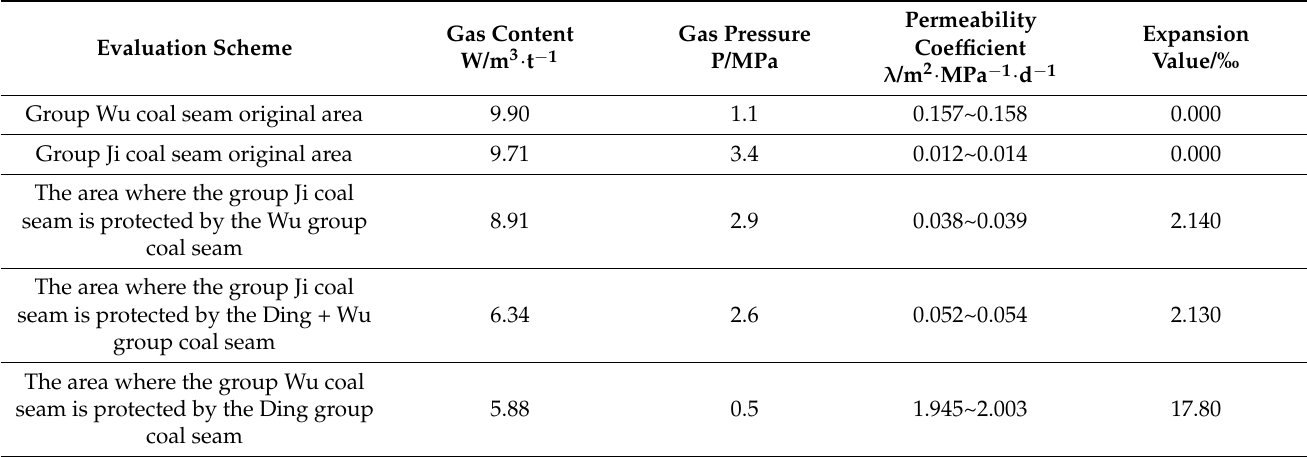
Table 4. Original test data of evaluation